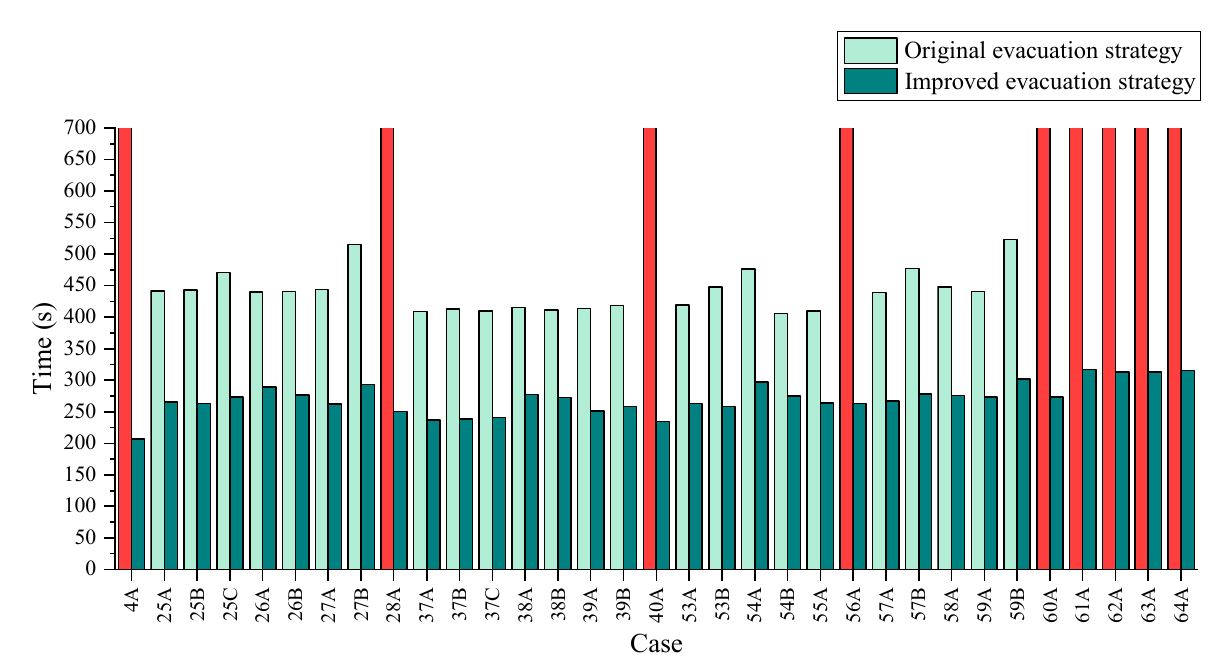
Figure 22. Comparison of evacuation time on the first floor before and after adding evacuation stairs.